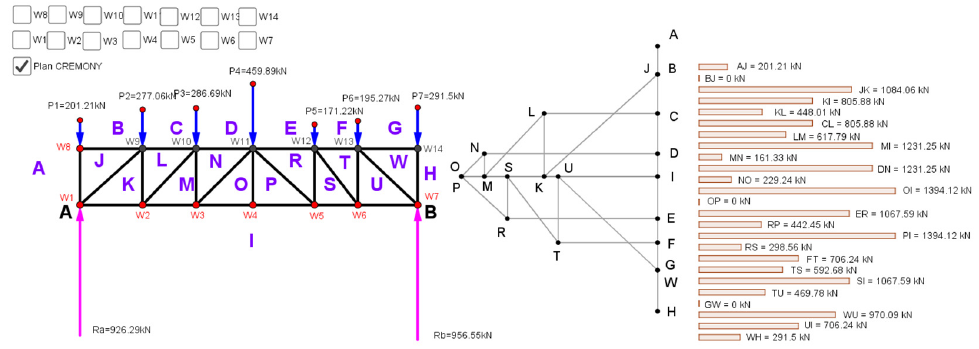
Figure 2. Example of a truss with form diagram ( left ) and force diagram ( right ) made by Author in. GeoGebra